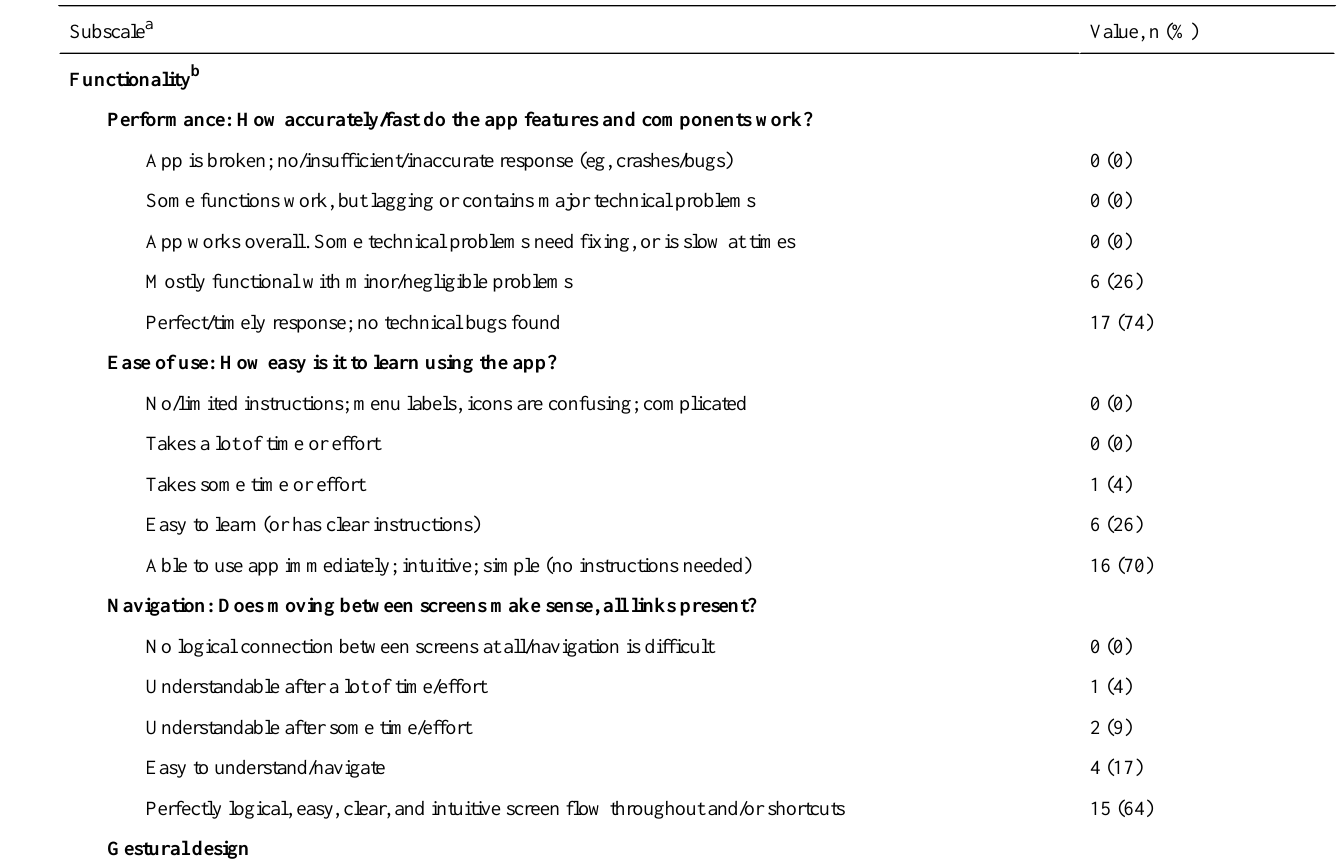
Table 3. Results from the Mobile Application Rating Scale (participants,